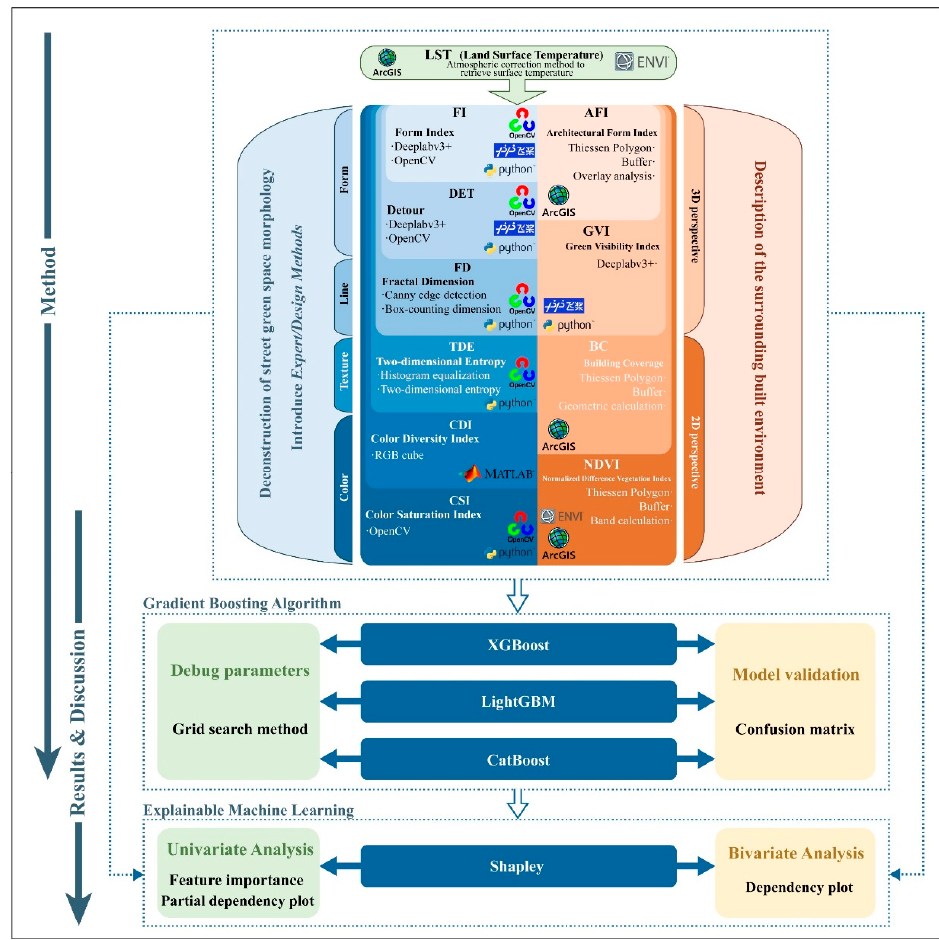
Figure 1. Research process overview.